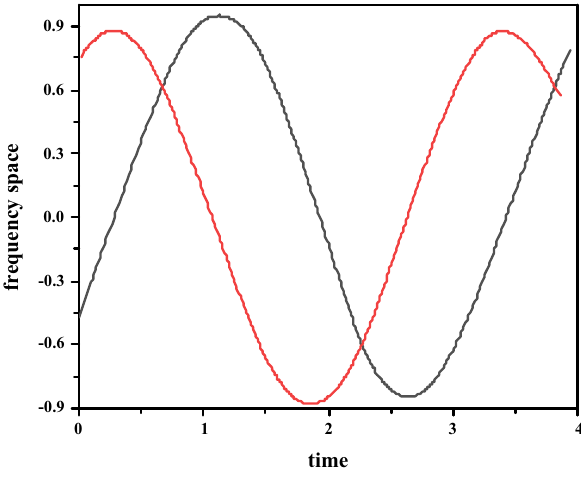
Figure 2: Example of real - time